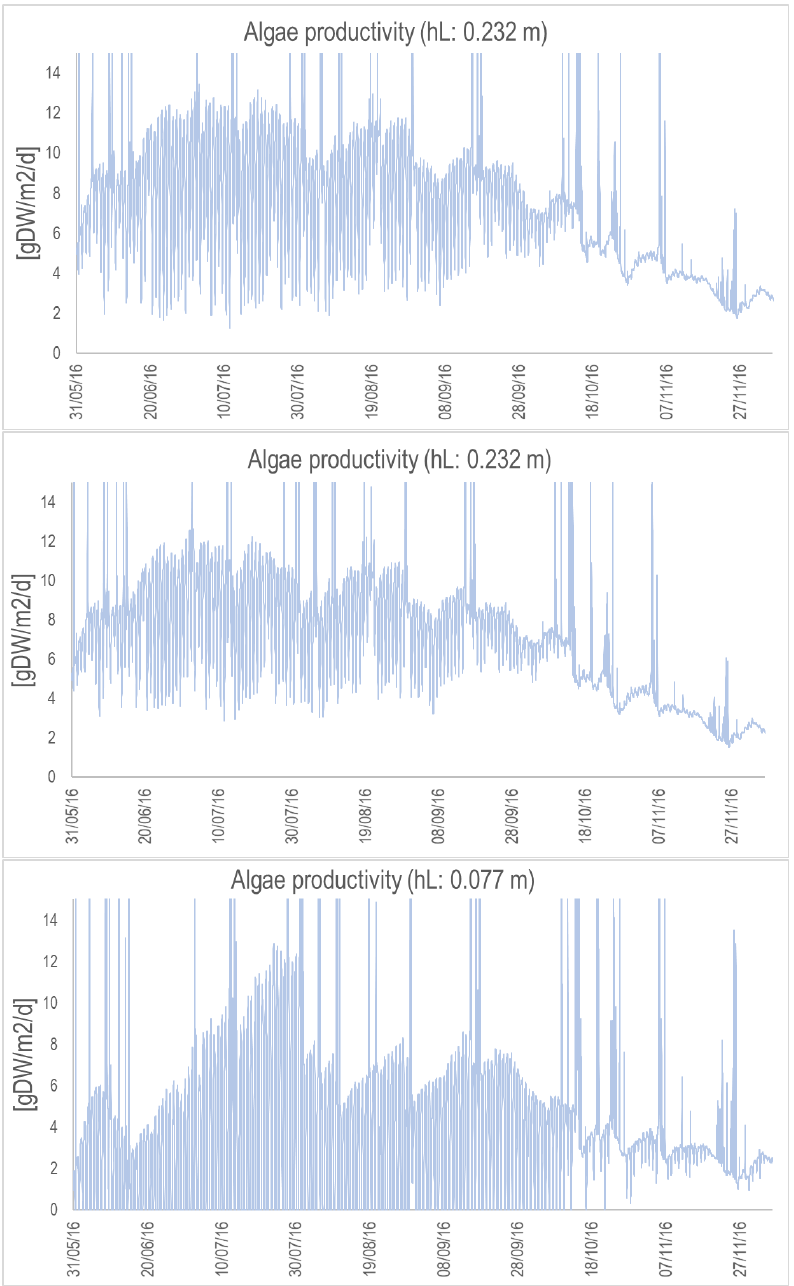
Figure A6. Algal productivity (in gDW/m 2 /d) for the suspended raceway with the nominal depth ( top ), depth divided by 2 ( middle ), and depth divided by 3. ( bottom ). Simulations are from May to November